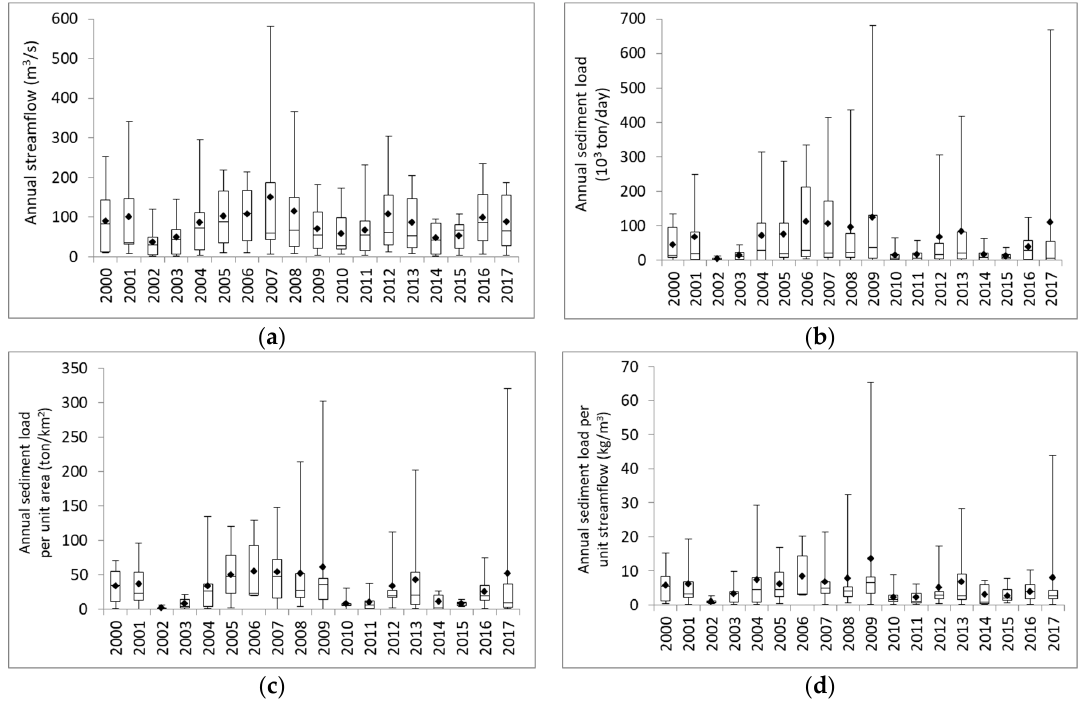
Figure 6. Temporal variation of annual streamflow and sediment load. ( a ) Annual streamflow; ( b ) Annual sediment load; ( c ) Unit-area sediment load; ( d ) Unit-discharge sediment load (Note: dots denote the average value of the data).